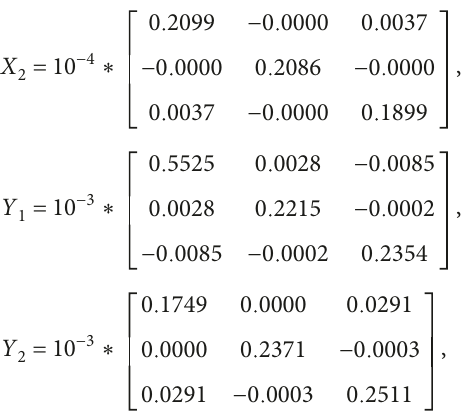
Figure 1: The real trajectories of mRNA concentration ( m t , x